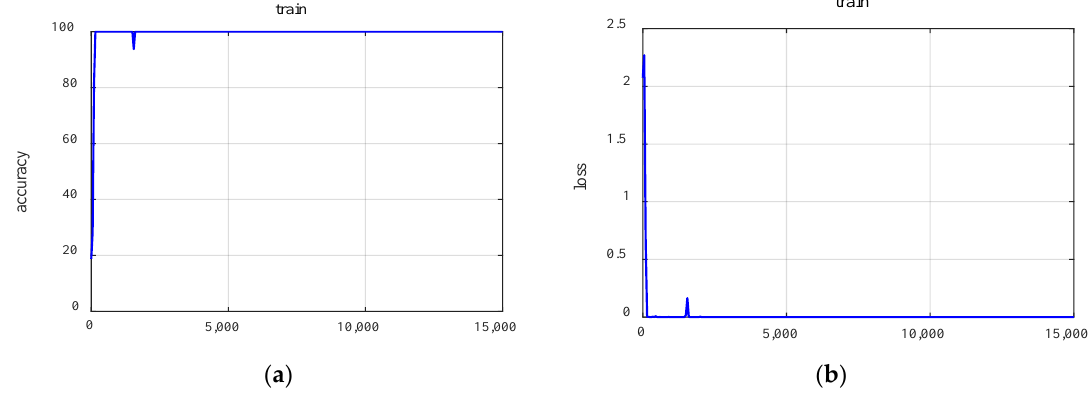
Figure 6. Accuracy and loss function curves for the training data. ( a ) Accuracy curve; ( b ) Loss function curve.